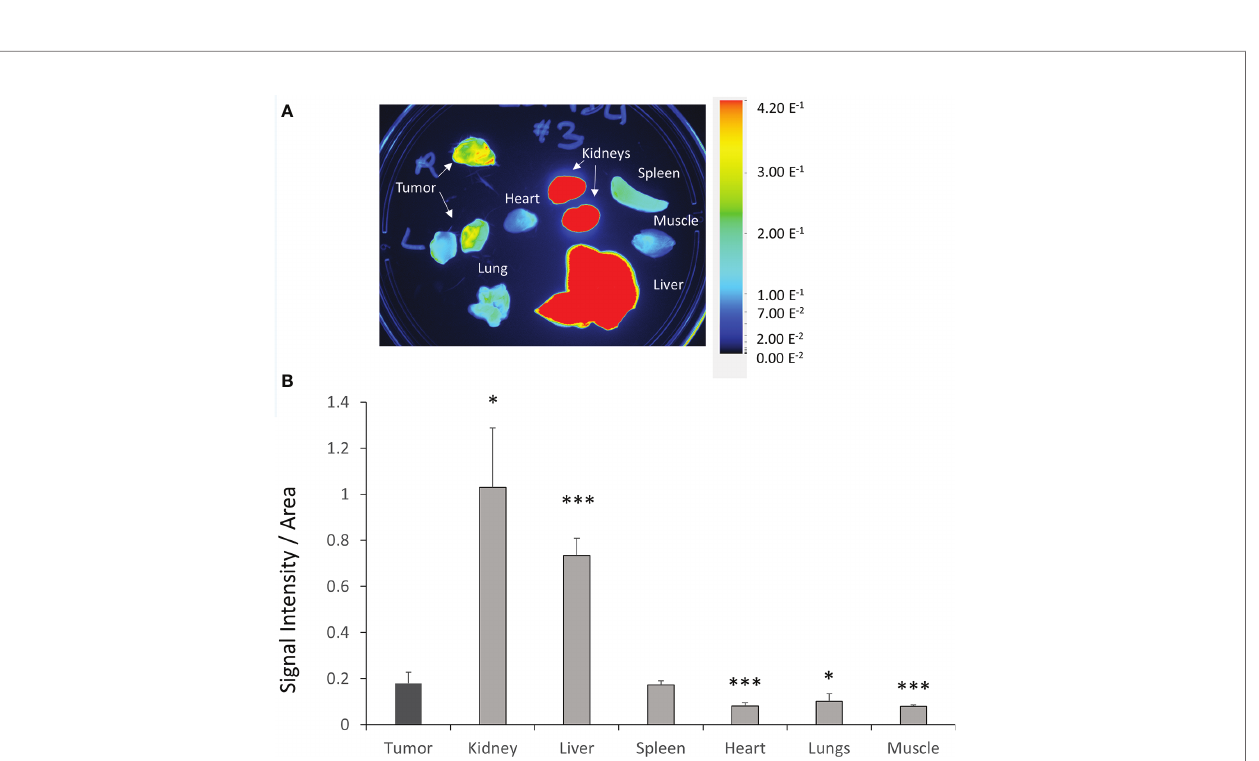
FIGURE 4 | Ex vivo PD-L1 siRNA dextran NP biodistribution in subcutaneous tumors. (A) Representative ex vivo images acquired from subcutaneous MDA-MB-231 tumors, kidneys, liver, spleen, lungs, heart, intestine, and muscle 24 h after the second injection of PD-L1-siRNA-dextran NPs. (B) Quanti fi cation of fl uorescent signal in subcutaneous MDA-MB-231 tumors, kidneys, liver, spleen, lungs, heart, intestine, and muscle measured ex vivo 24 h after the second PD-L1-siRNA dextran NP injection (group 1, n = 6). *p < 0.05, ***p < 0.005 compared to the fl uorescent signal measured in the